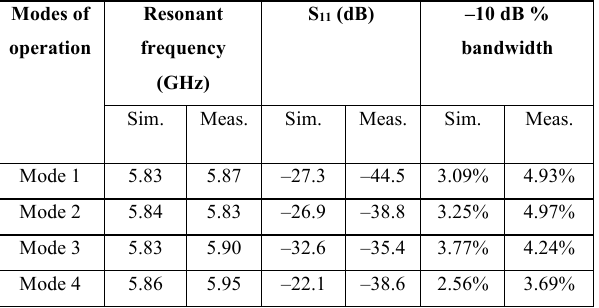
FIGURE 8. E and H plane radiation pattern (a) Mode 1, (b) Mode 2, (c) Mode 3 and (d) Mode